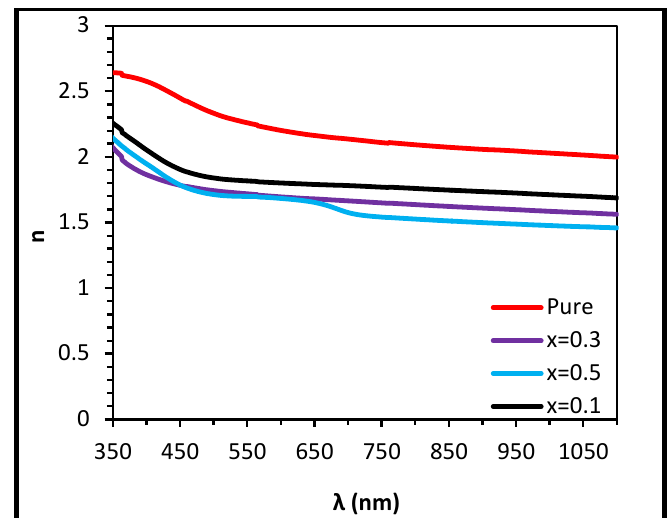
Fig.5: Optical refractive index for V